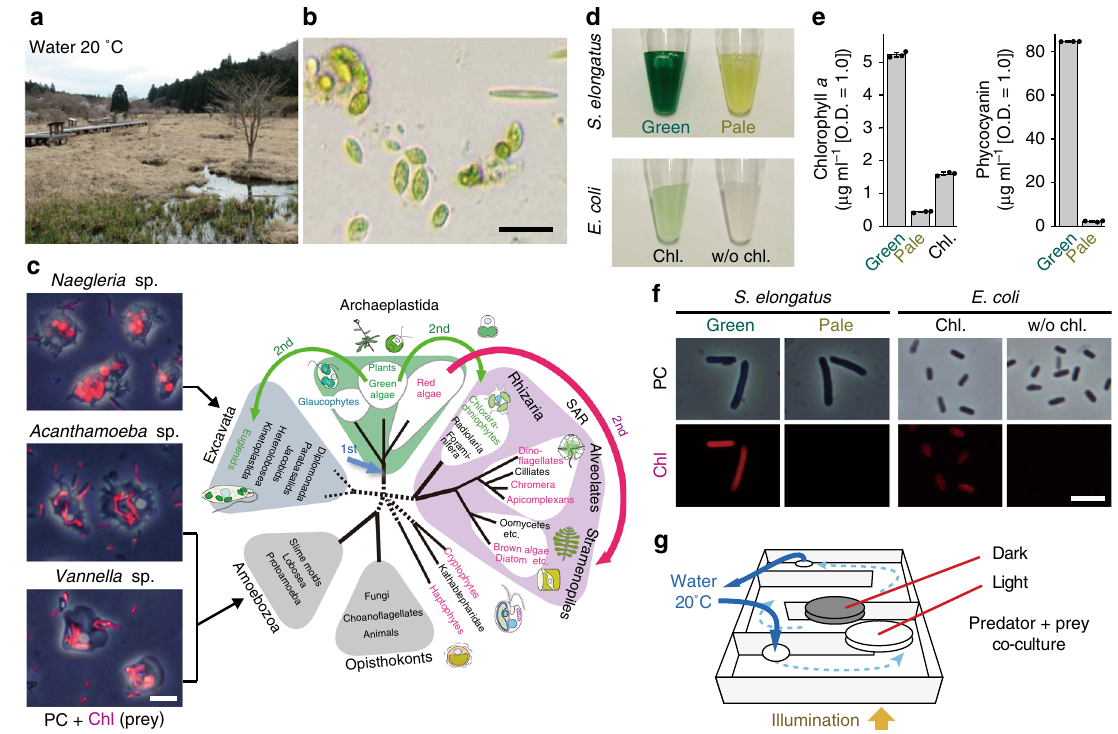
Fig. 1 Habitat and isolation of the amoebozoan and excavate predators, preparation of bacterial prey, and co-cultivation conditions. a Water and soil samples were collected from Kodanuki marsh in Japan to isolate ameboid predators. b Micrograph of the sample showing the existence of unicellular algae. Scale bar = 50 μ m. c Three excavate and amoebozoan species that fed on the cyanobacterium S . elongatus . Images of phase-contrast microscopy (PC) and S . elongatus red chlorophyll fl uorescence (Chl) are merged. The phylogenetic tree is according to ref. 16 . Scale bar = 10 μ m. d Normal (green) and pale S . elongatus prey. The pale prey was prepared by cultivating the cells on nitrogen-depleted medium to reduce photosynthetic pigment levels (chlorophyll a and phycobilins). E . coli cells were incubated in acetone with (Chl) or without (w/o Chl) chlorophyll a , dried, and then rehydrated. e Chlorophyll a and phycocyanin levels of respective bacterial prey. The error bar represents s.d. of three independent cultures (cultured at the same time). Source data are provided as a Source Data fi le. f Micrographs of respective bacterial prey. The excitation strength for E . coli was 66.7 times stronger than that for S . elongatus for chlorophyll fl uorescence (Chl) imaging. Scale bar = 5 μ m. g The excavate and amoebozoans and bacterial prey were co-cultivated in Petri dishes. The dishes were put on a transparent box in which water at 20 °C was circulated. Dishes were illuminated from the bottom of the